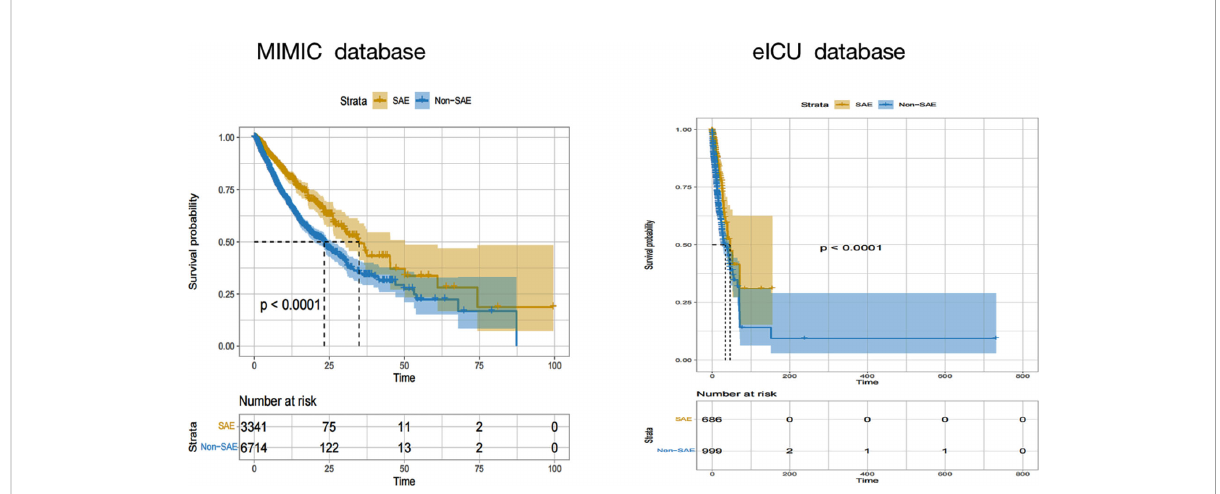
FIGURE 4 Kaplan-Meier hospital survival curves for SAE patients. SAE, sepsis-associated